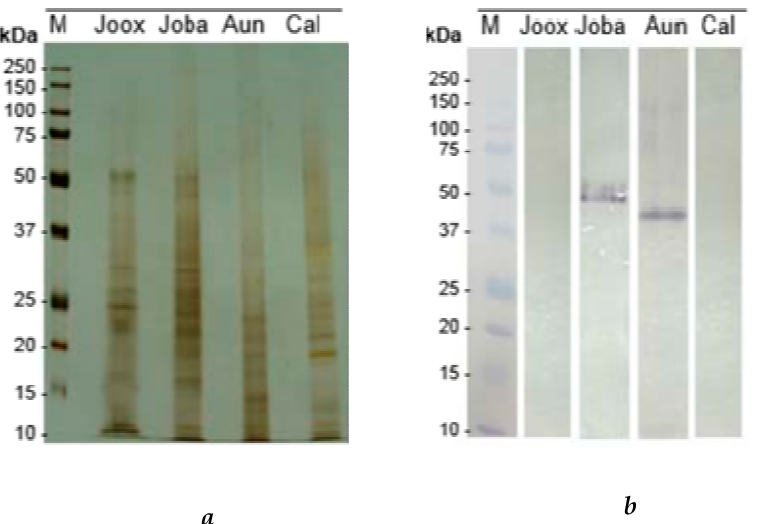
Figure 4. Glycoprotein detection in protein leaves extracts. Polypeptide profile of Juniperus oxycedrus subsp. oxycedrus (Joox), Juniperus oxycedrus subsp. badia (Joba), Arbutus unedo (Aun) and Corema album (Cal) leaves extracts in a 17.5% SDS-PAGE-R ( m / v ) acrylamide, stained by AgNO3 as gel control. It was applied 7 µ g of each extract and 3 µ g of molecular marker (a). Transfer and glycodetection in a nitrocellulose membrane of leaves extracts: were transferred 540 µ g of Joox, 700 µ g of Joba, 350 µ g Aun and 400 µ g of Cal, of the respective extracts (b).